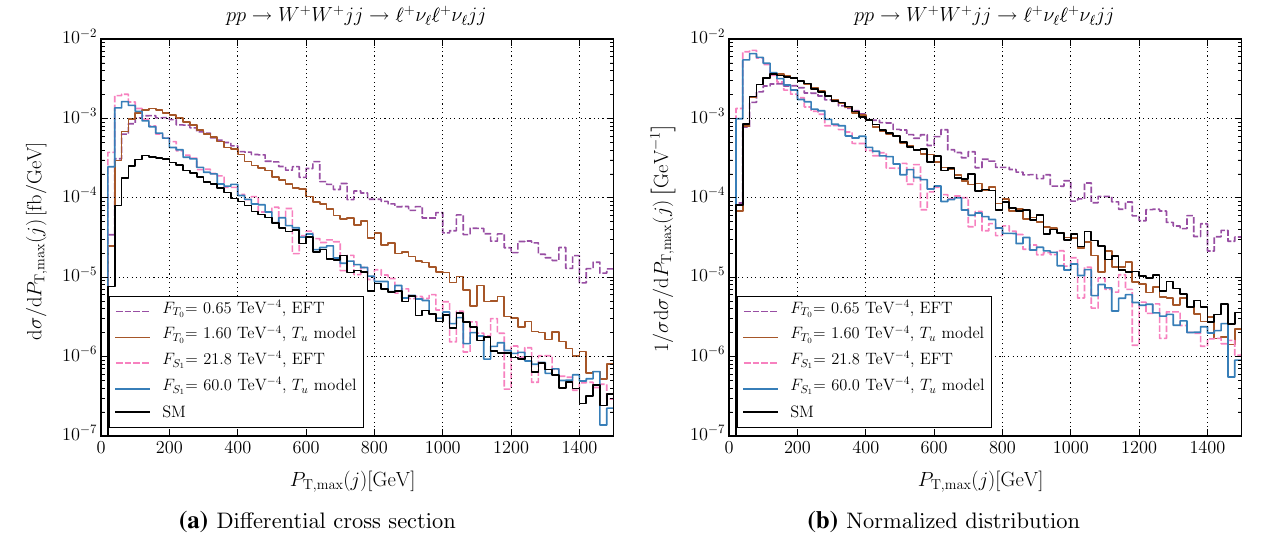
Fig. 6 Differential cross section as a function of p T , max ( j ) for pp → (cid:6) + ν (cid:6) (cid:6) + ν (cid:6) jjX . The solid black line shows the SM, the dashed lines show the naive EFT prediction within present CMS bounds, and the